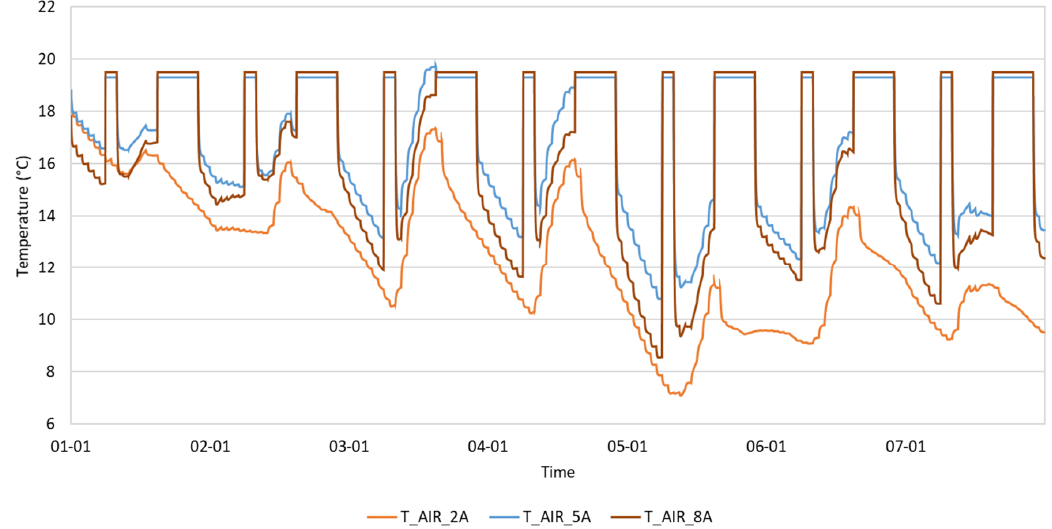
Figure 10. Indoor temperature variation of apartments 2A, 5A and 8A in a representative week of the heating season, scenario b.